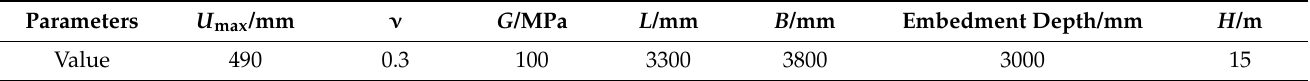
Table 6. Value of the input parameters.